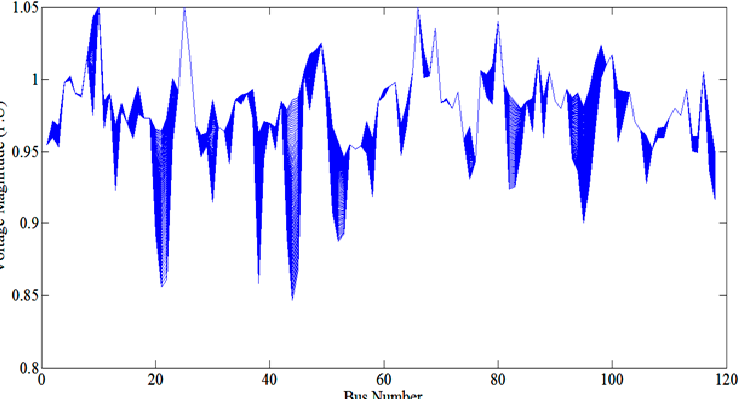
Figure 16. The voltage amplitude profile in terms of the load demand increment in the MLP with the IEEE 118-bus test system.